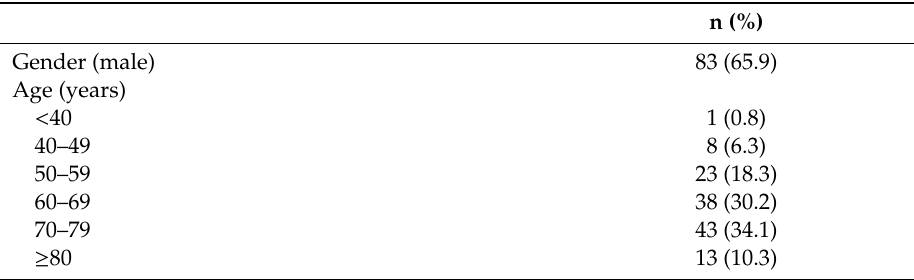
Table 1. Characteristics of the survey respondents ( n =